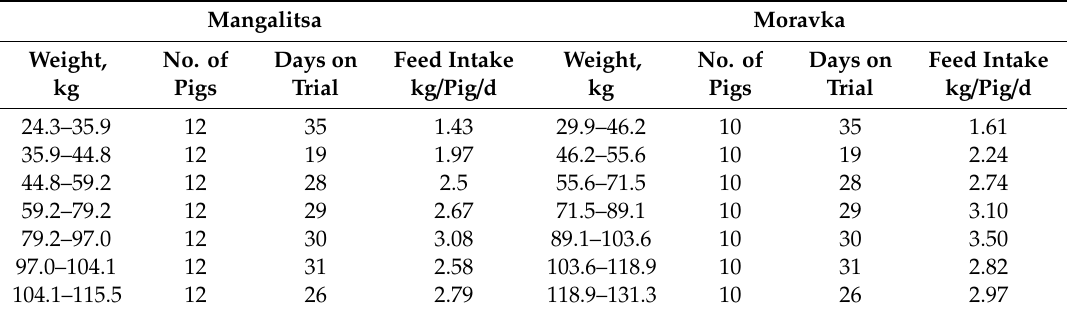
Table A9. Data on Mangalitsa (Swallow-Belly type) and Moravka breeds used for modelling (Project TREASURE) 1